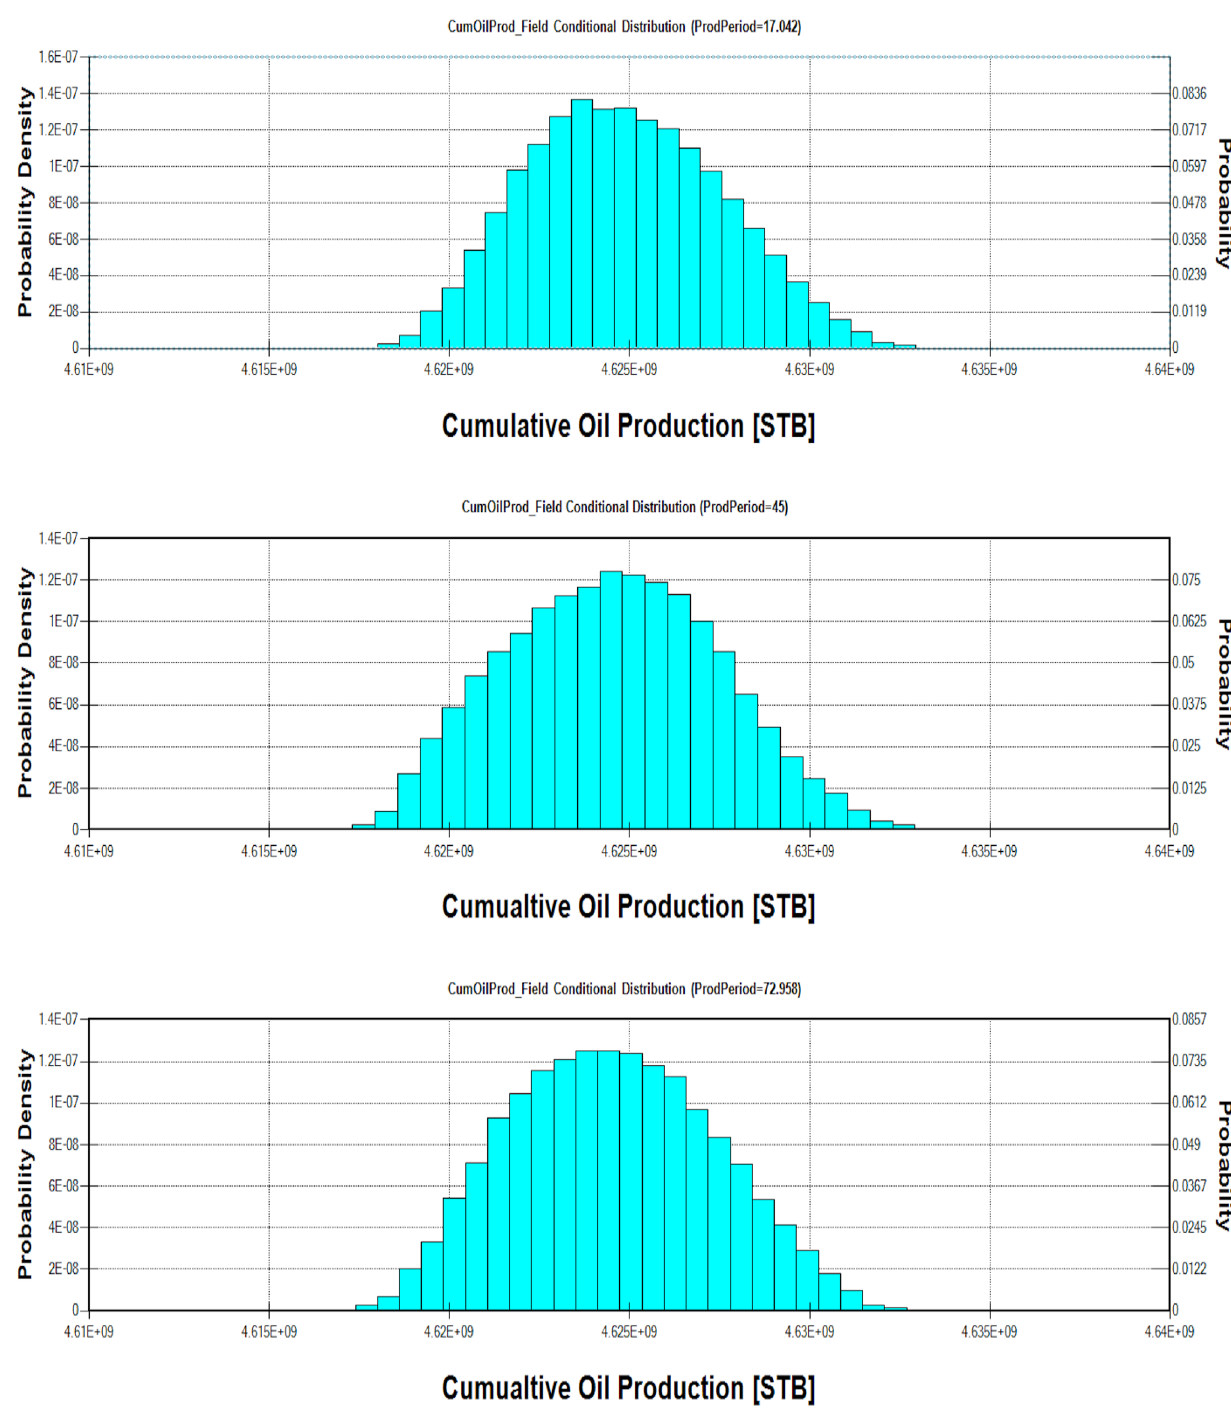
Fig. 21 Probability distribution of flow response as a function of production